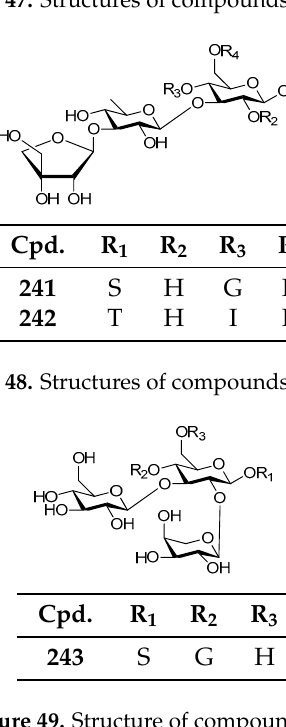
Figure 47. Structures of compounds 239 – 240 . Molecules 2016 , 21 , 1402